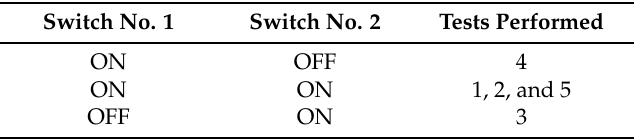
Table 1. Summary of switch positions for test Table 1 . Summary of switch positions for test conditions.